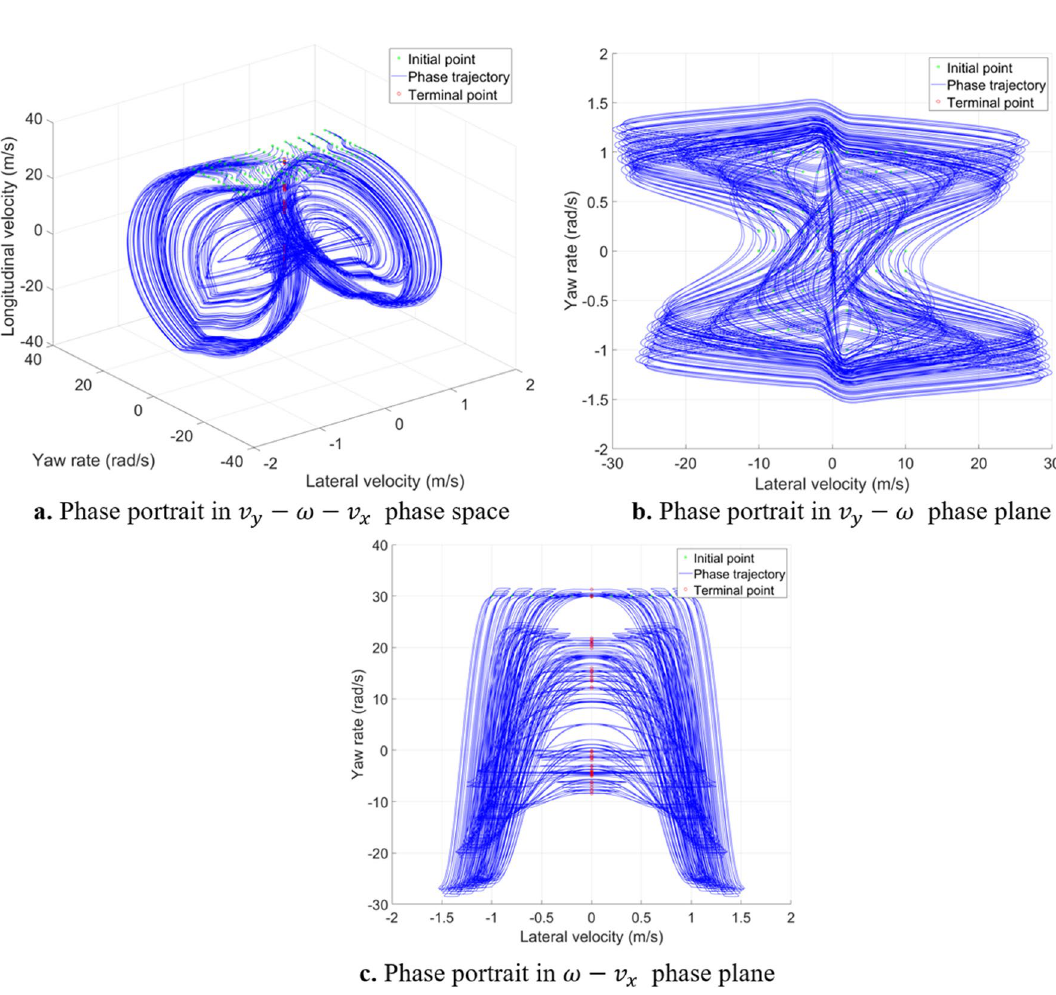
Figure 8. Phase portrait of 3-DOF vehicle